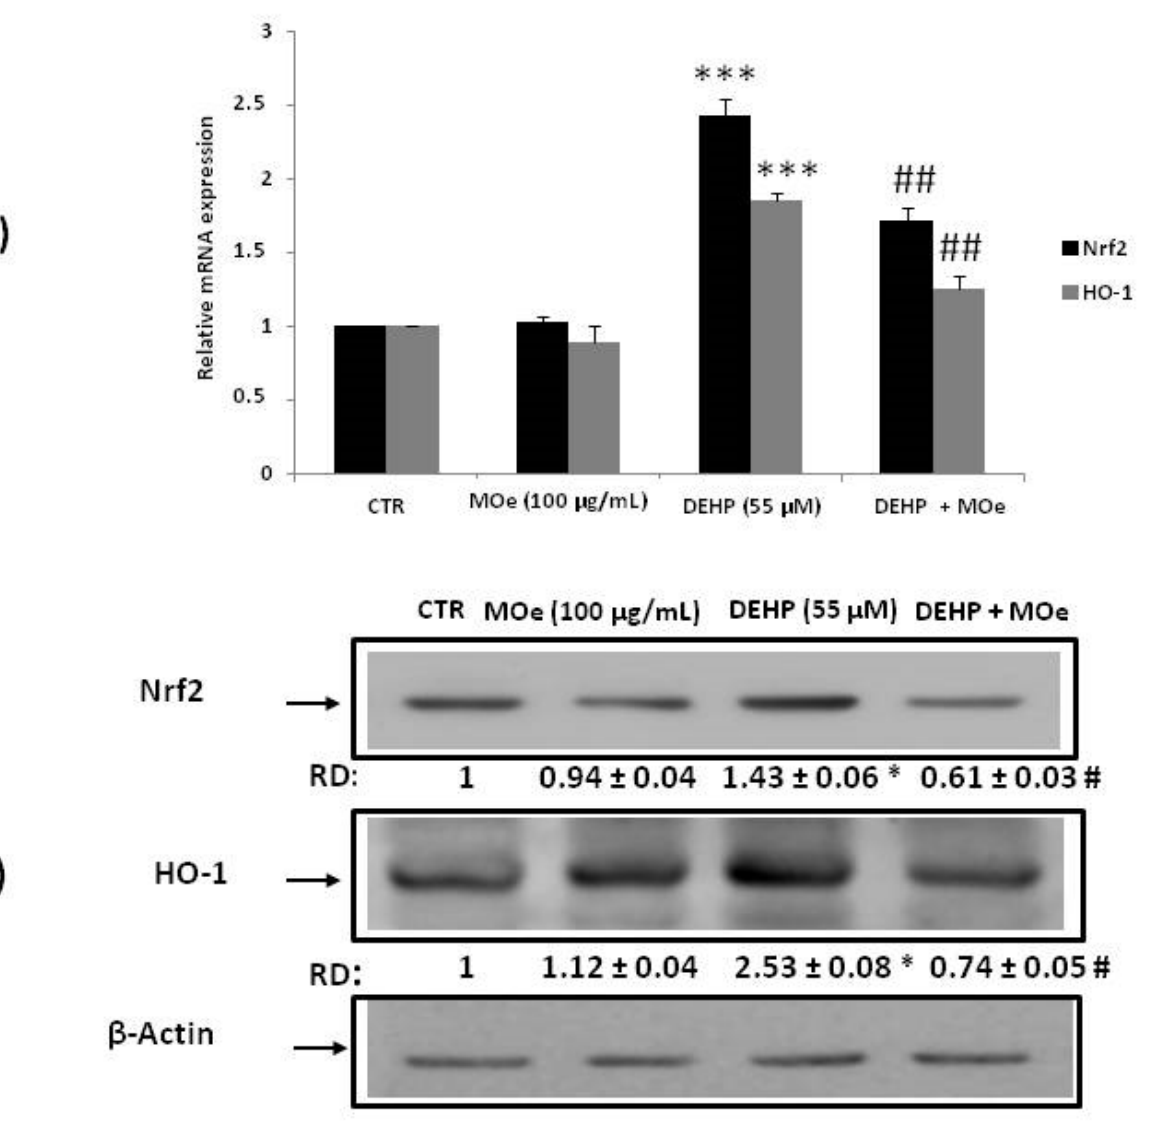
Figure 6. Effect of MOe on DEHP-induced upregulation of Nuclear factor erythroid 2-related factor (Nrf2) and Heme oxygenase 1 (HO-1). SH-SY5Y cells were pretreated with MOe (100 µ g/mL) for 2 h before DEHP treatment for 24 h (55 µ M). ( A ) Nrf2 and HO-1 relative mRNA levels were determined by quantitative Real Time (qRT)-PCR and expressed as fold change over untreated controls ( B ). As a loading control, we have used β -actin. RD: relative density as described in the Material and Methods Section.Values represent mean ± SD of three independent experiments. * p < 0.05 vs. control, *** p < 0.001 vs. control and # p < 0.05 vs. DEHP alone, ## p < 0.01 vs. DEHP alone.